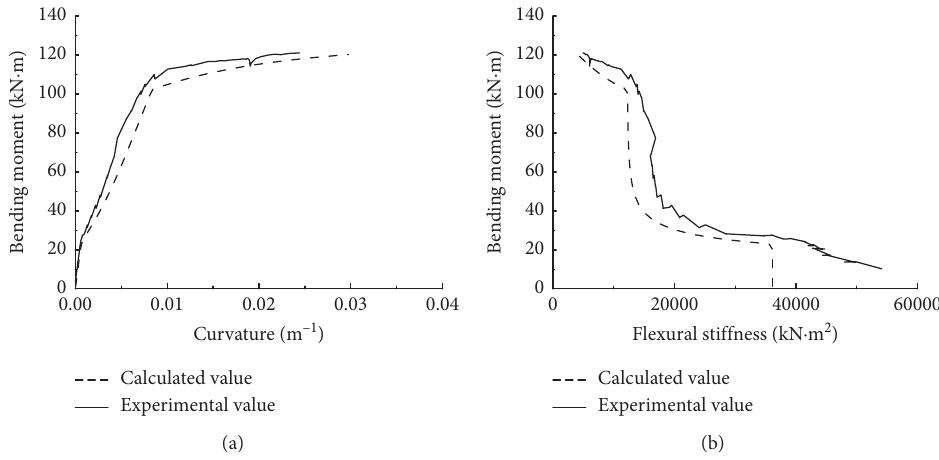
Figure 19: Beam B-1-30-6. (a) Bending moment-curvature curve. (b) Bending moment-stiffness